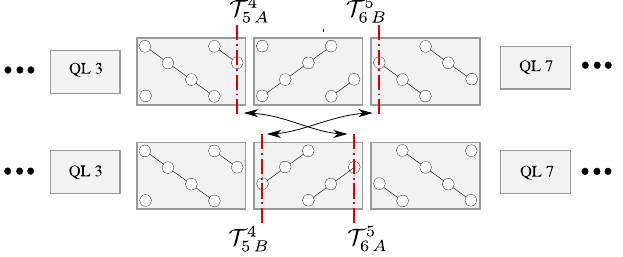
Figure 11. Sketch of the interchange of the AB TP order with the BA one in the case of gathered